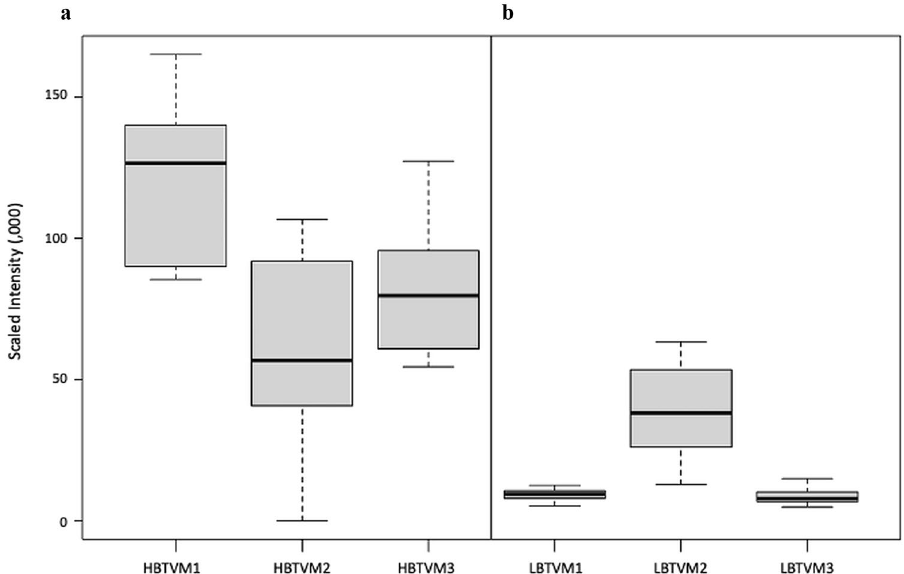
Figure 2. Box-whisker plots representing pareto-scaled intensities of selected High- and Low-Between Timepoint Variability Metabolites (HBTVM and LBTVM, respectively). ( a ) HBTVM1: 1-Linoleoyl-sn-glycero- 3-phosphocholine, HBTVM2: 1-Oleoyl-sn-glycero-3-phosphocholine, HBTVM3: 1-Palmitoyl-sn-glycero- 3-phosphocholine. ( b ) LBTVM1: pro-pro-pro, LBTVM2: l-Isoleucine, LBTVM3: l-Glutamic acid. The bold dark vertical line of the box-whisker plot indicates the median CV, the top and bottom ends of the rectangle are indicative of 25th and 75th percentiles and the whiskers measure the 95% confidence